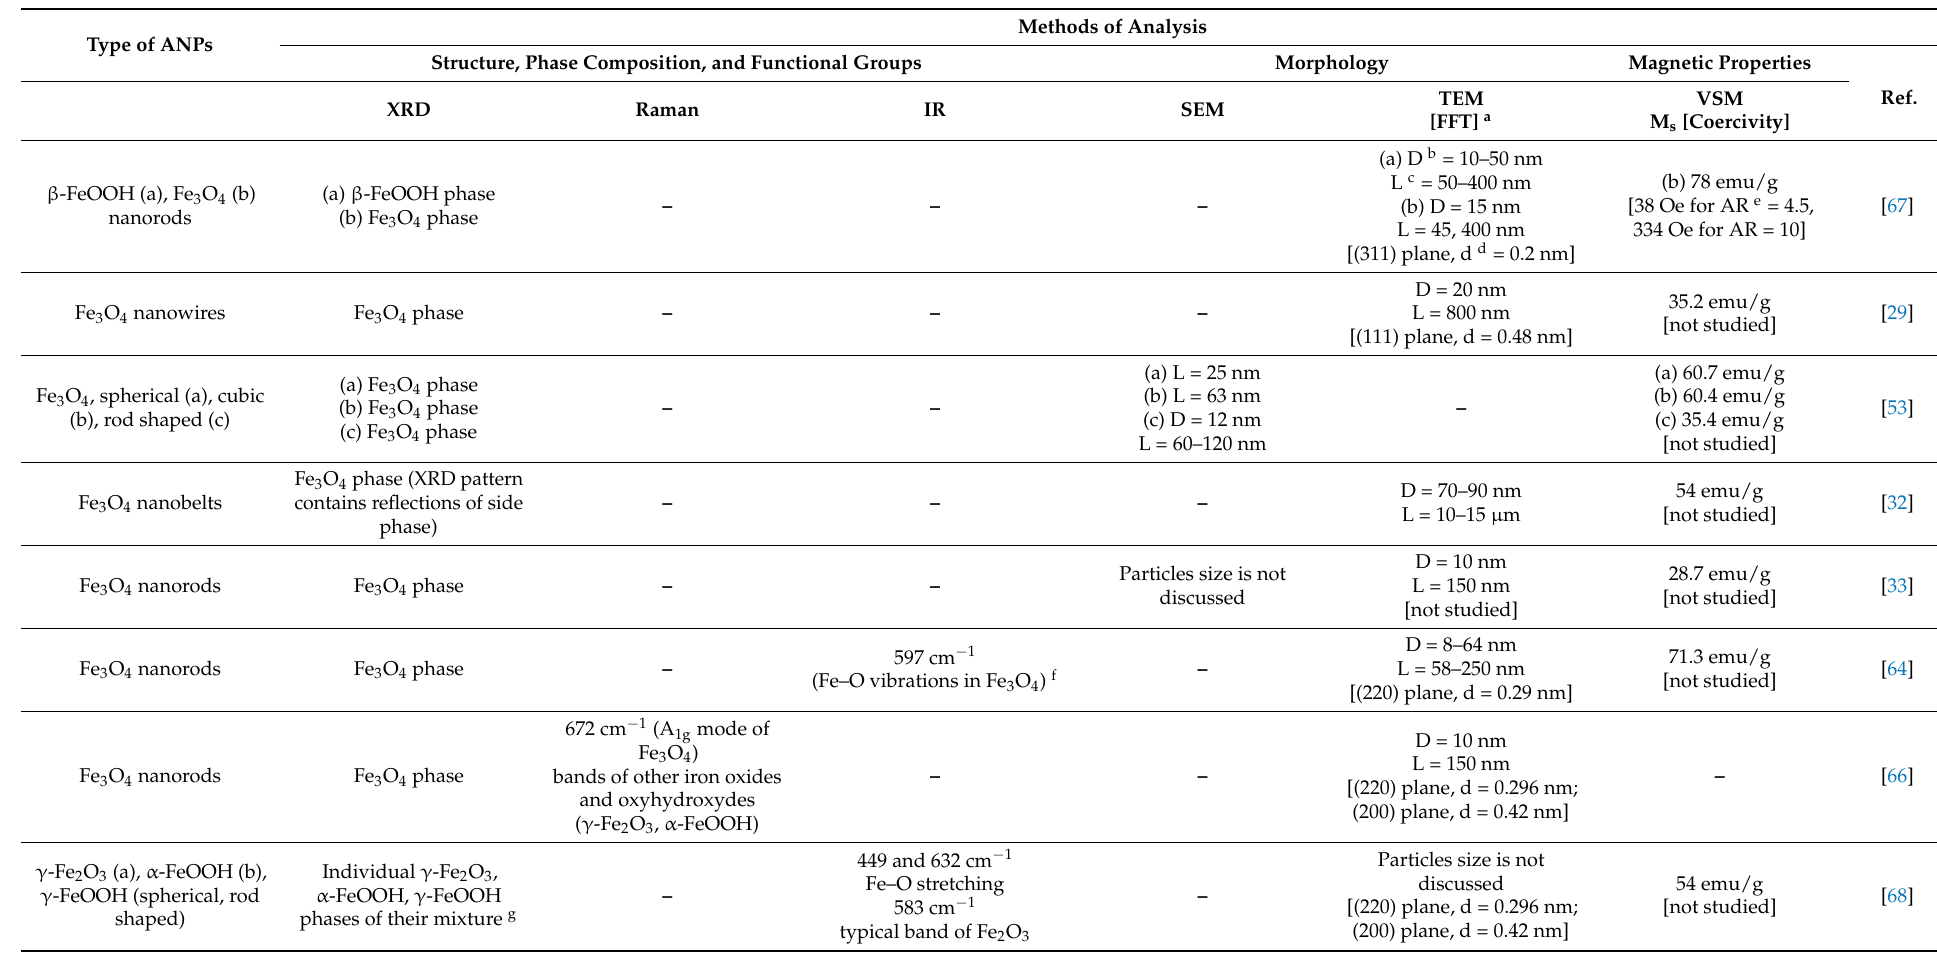
Table 5. Characterization methods for a study of iron oxide and oxyhyroxide ANPs presented in some